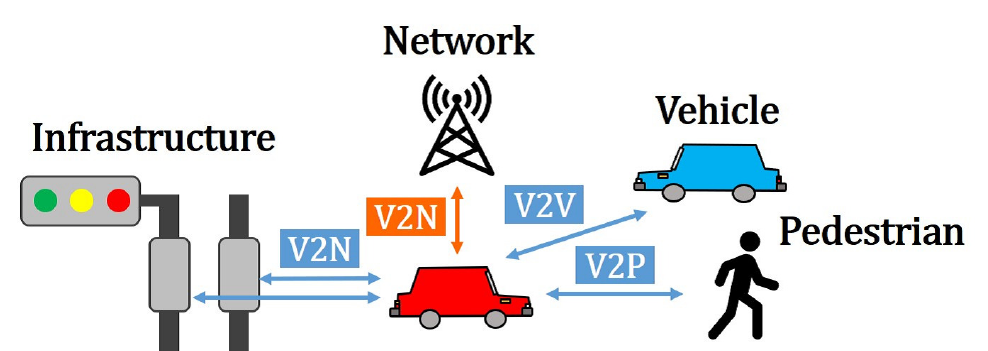
Figure 1. LTE V2X